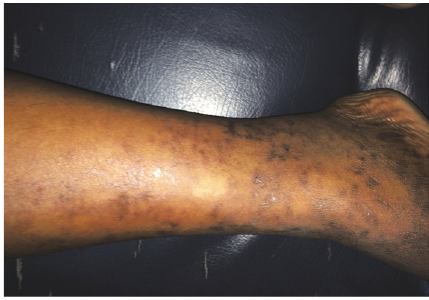
Figure 1: Livedo reticularis of right leg.